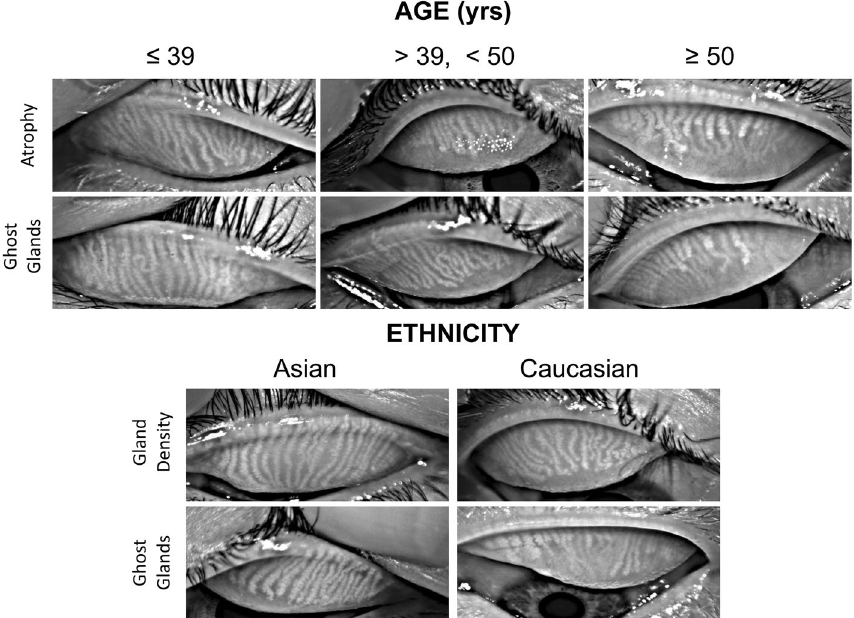
Figure 6. Meibography images stratified on age and ethnic group, illustrating the most highly weighted Meibomian gland morphological features used by the prediction model. Older subjects exhibited more MG atrophy and ghost glands. Caucasian subjects exhibited lower gland density and more ghost glands compared with Asian subjects.